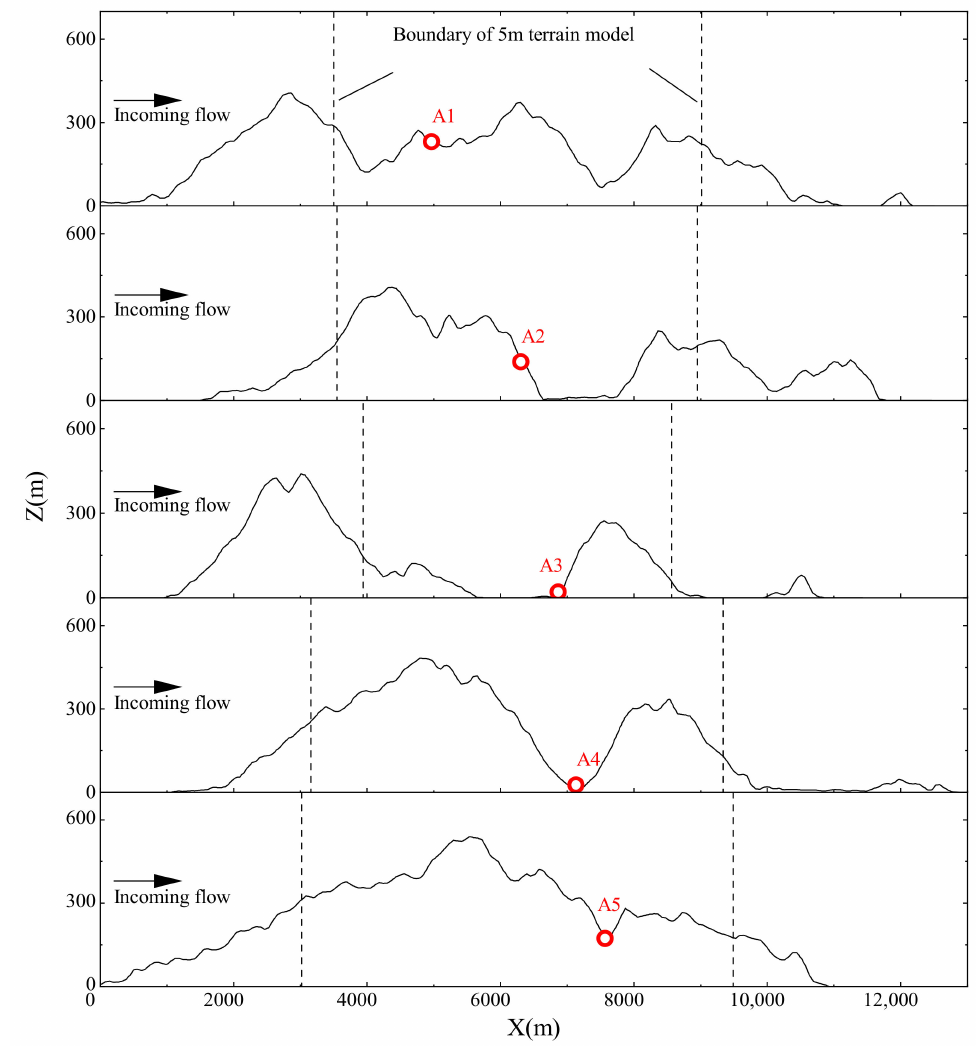
Figure 5. East-West cutting planes of measurement locations: (A1) location A1; (A2) location A2; (A3) location A3; (A4) location A4; (A5) location